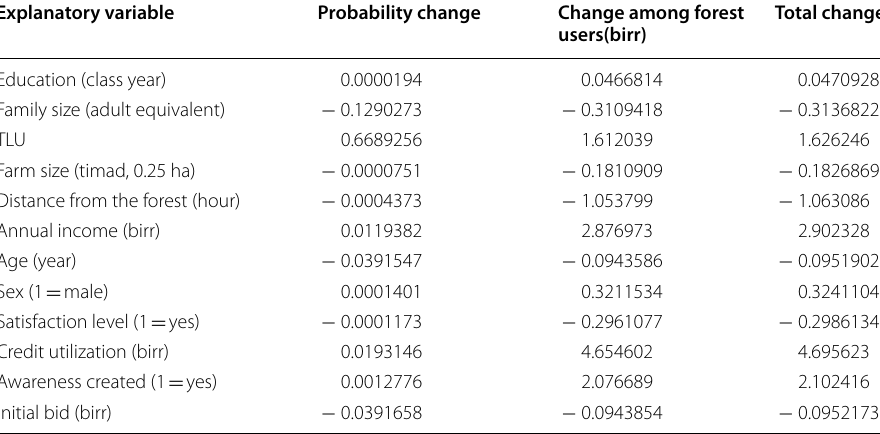
Table 7 The amount of willingness to pay from the results of marginal effects of independent variables . Source: Author’s computation,